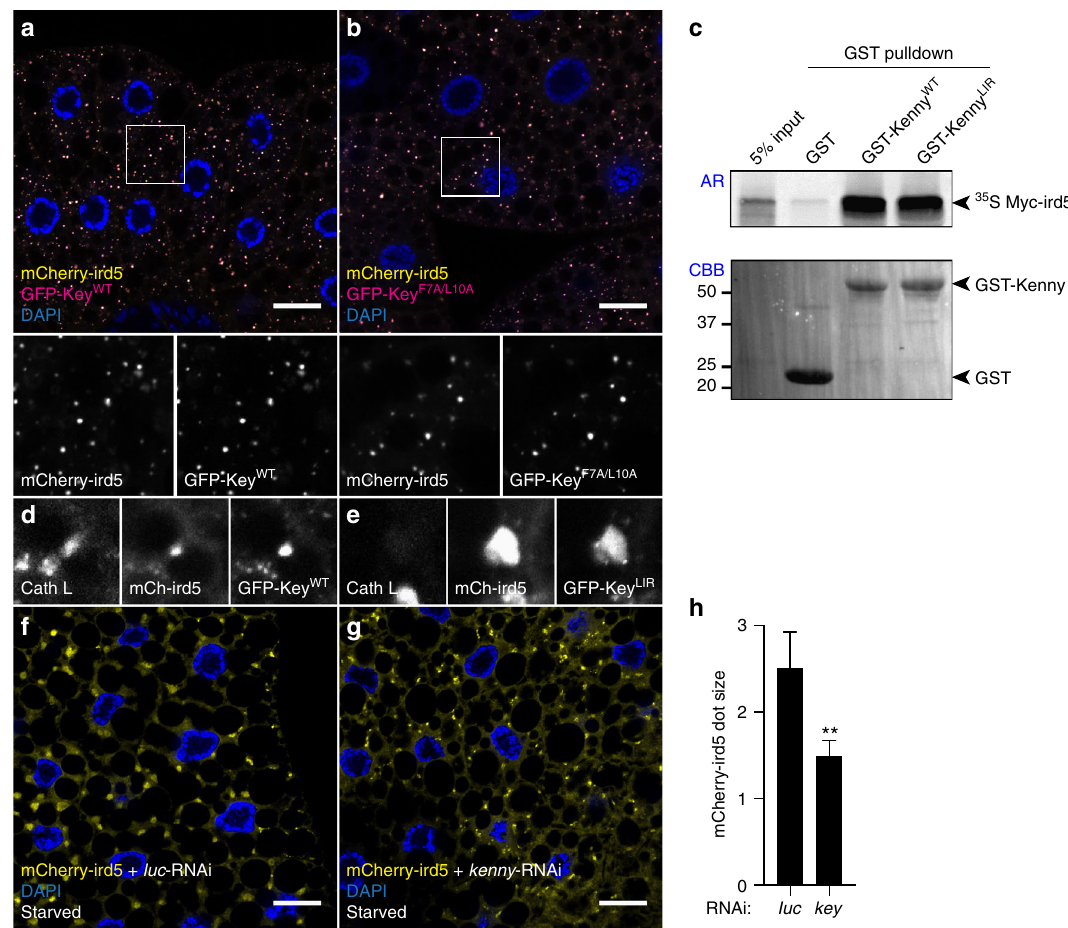
Fig. 7 Localization of ird5 in lysosomes. a , b Confocal images of fat body cells from fed larvae co-expressing mCherry-ird5 (yellow) and GFP fusion proteins of Kenny WT a or Kenny F7A/L10A (magenta) b . Insets show the separate channels for mCherry-ird5 (lower left) and GFP-Kenny (lower right). c In vitro GST- pull-down assay between GST-tagged Kenny (lower panel, Coomassie Blue), and radiolabelled Myc-ird5 (upper panel) produced by coupled in vitro transcription and translation reaction in the presence of 35 S-methionine. d , e Magni fi cation of confocal images of fat body cells from starved larvae co- expressing GFP-Kenny WT ( d , GFP-Key WT ) or GFP-Kenny F7A/L10A ( e , GFP-Key LIR ), stained for Cathepsin-L. f , g Confocal images of fat body cells from starved larvae co-expressing a control luciferase RNAi ( f , luc -RNAi) or a RNAi against kenny ( g , key RNAi) along with mCherry-ird5 (yellow). h Quanti fi cation of the size of the mCherry-ird5 puncta. Bar chart shows means ± s.d. Statistical signi fi cance was determined using two-tailed Student ’ s t - test, ** P < 0.01. Scale bars are 20 µ